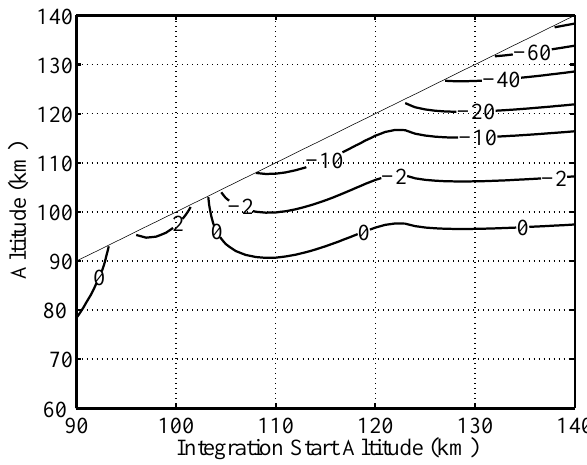
Fig. 8. Mid latitude – measurements made during quiet solar ac- tivity and processed assuming moderate solar activity, including the selection of the seeding temperature.